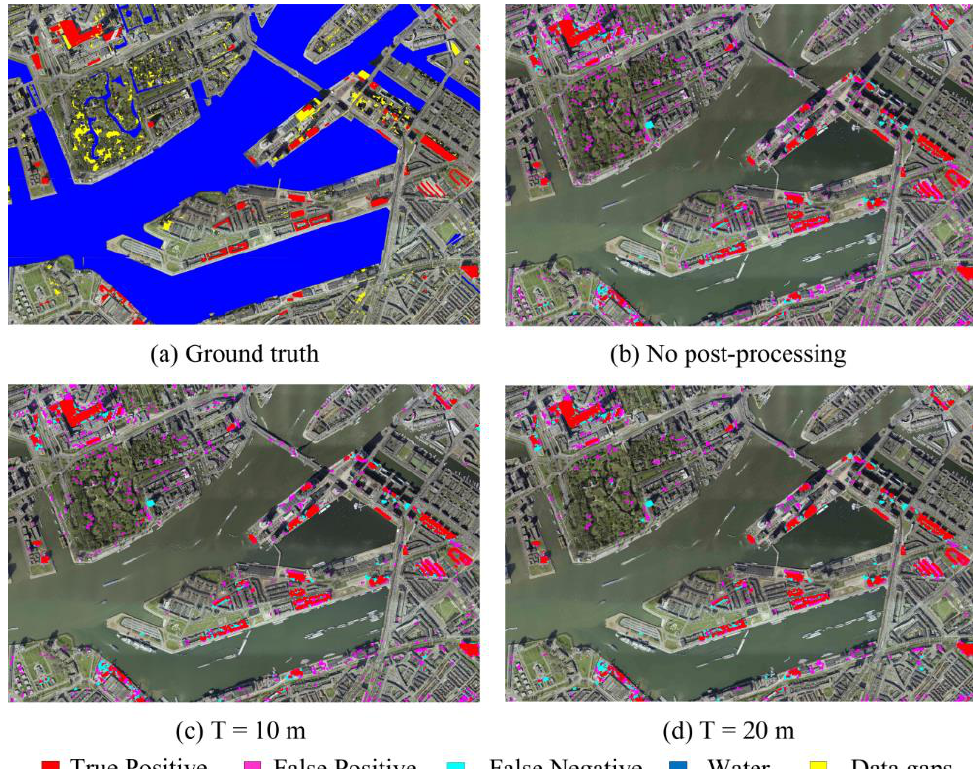
Figure 6. Change maps generated from model HHC-3convB . (a) Ground truth; (b) original change map without post-processing. (c) post-processed with T 3 = 10 m. (d) post-processed with T 3 = 20 m.